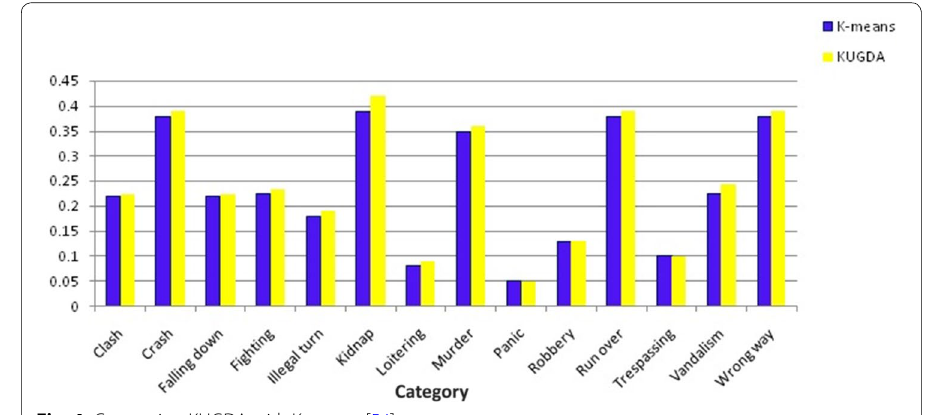
Fig. 4 Comparing KUGDA with K-means [54]